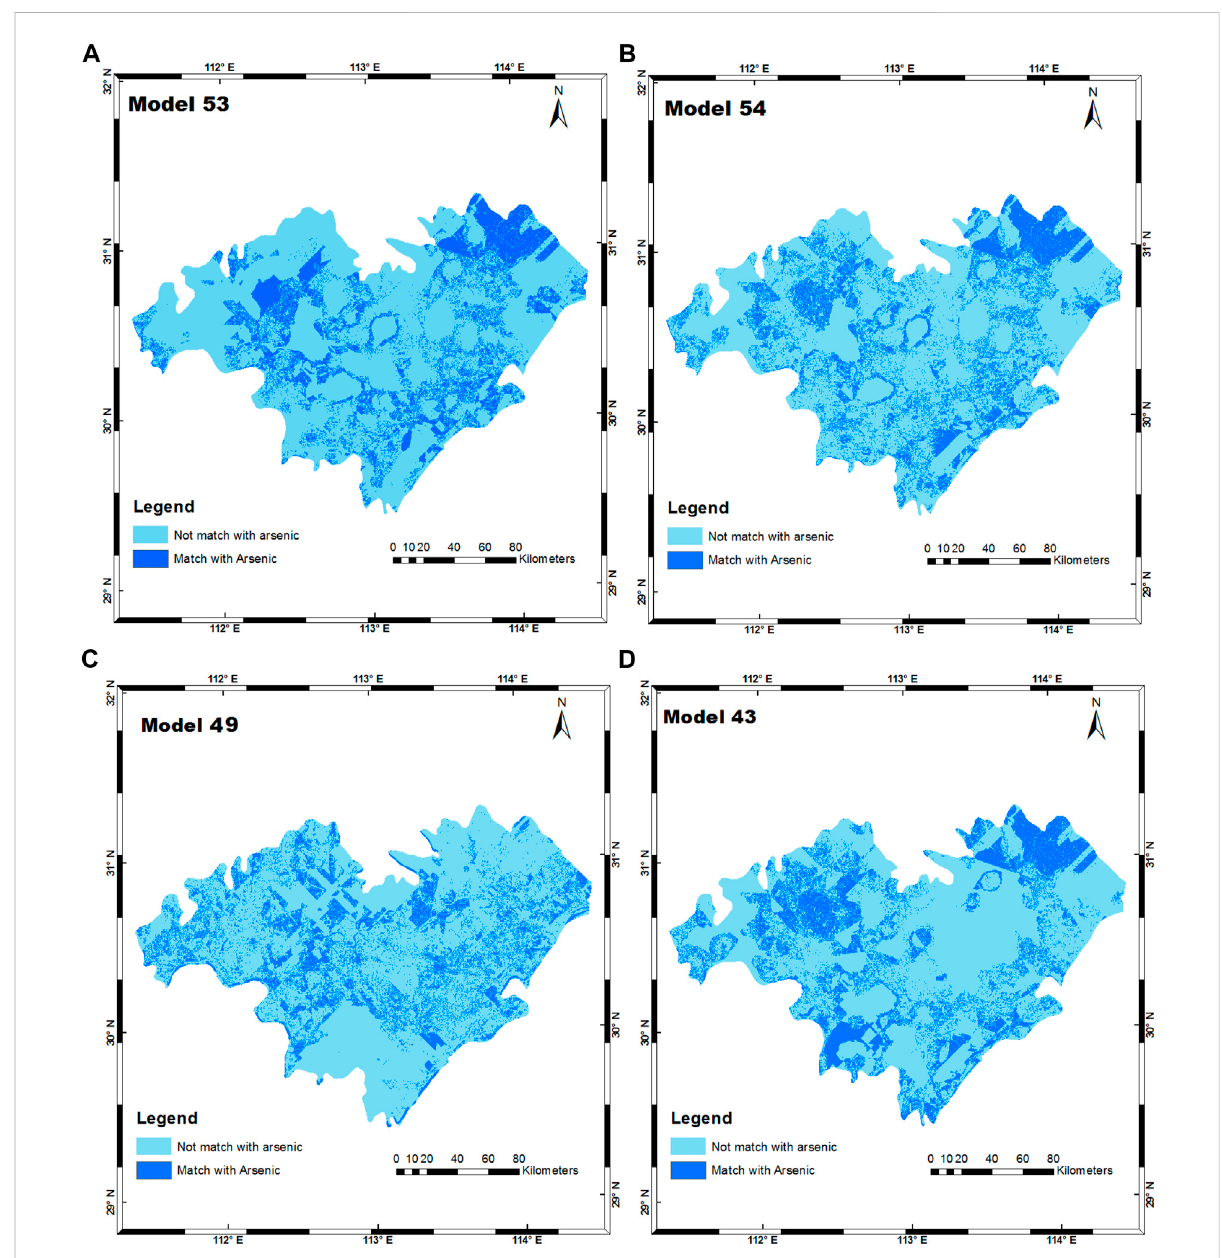
FIGURE 6 Final equal frequency maps of the best models for GW and SW arsenic concentrations: (A) W*Pop, (B) W*Pump, (C) W*(1Pump+2Pop), and (D)